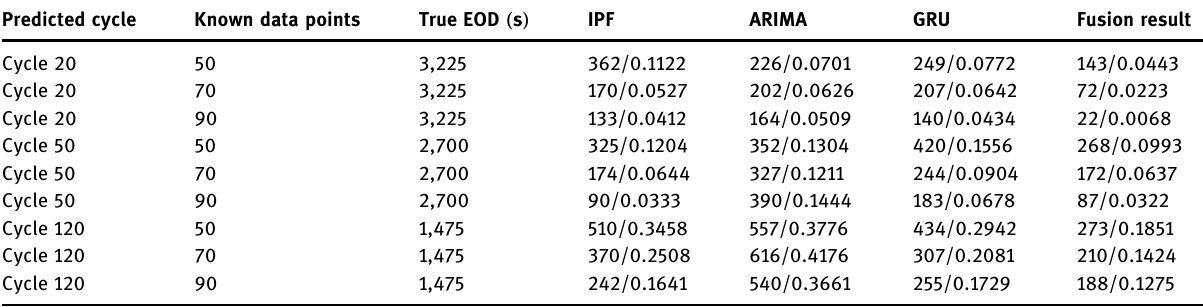
Table 1: MAE/MAPE of each prediction result Predicted